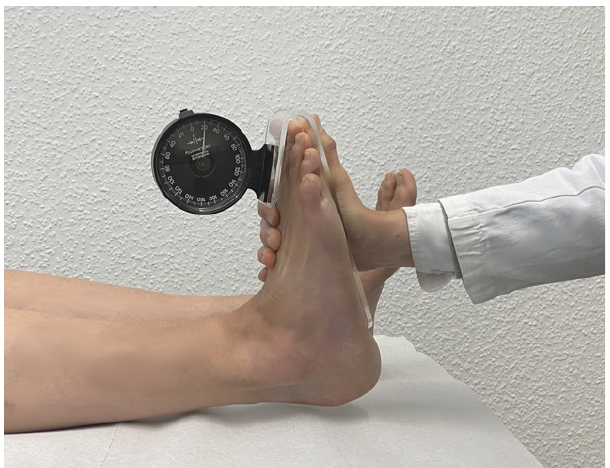
Figure 4. Subject in supine and plate of Pluri-Ped firmly pressed against sole of the foot to measure range of motion in ankle joint.